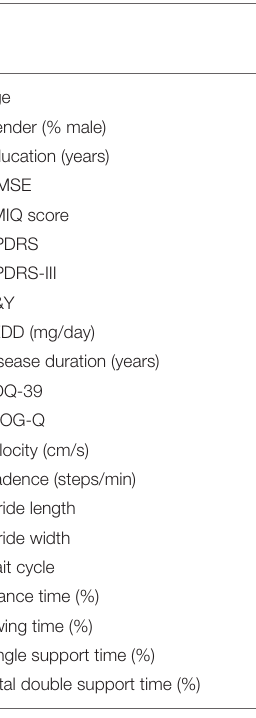
TABLE 1 | Demographic characteristics of PD FOG , PD NOFOG , and normal